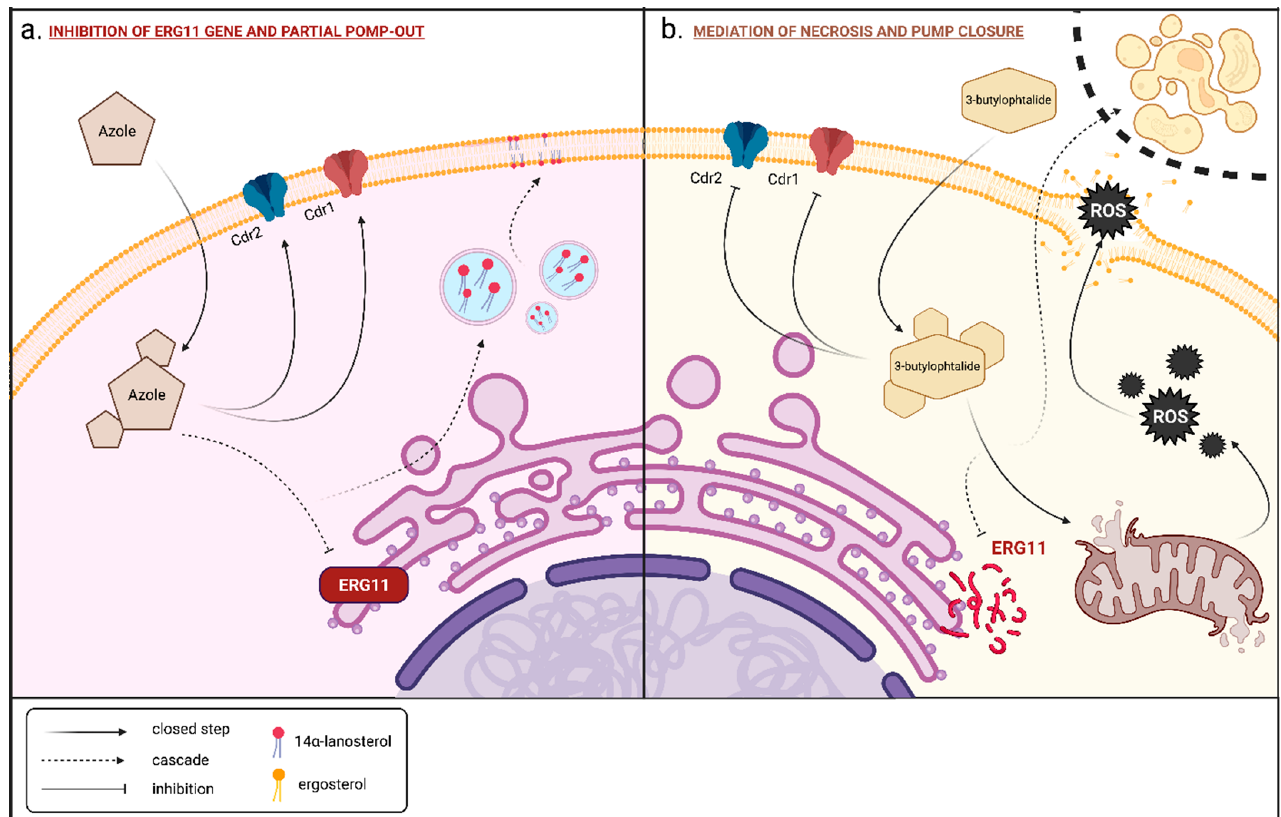
Figure 1. ( a ) Mechanism of action of 3-butylphalide on yeast cell metabolism. ( b ) Mechanism of effect of azole compounds on yeast cell (created in BioRender).